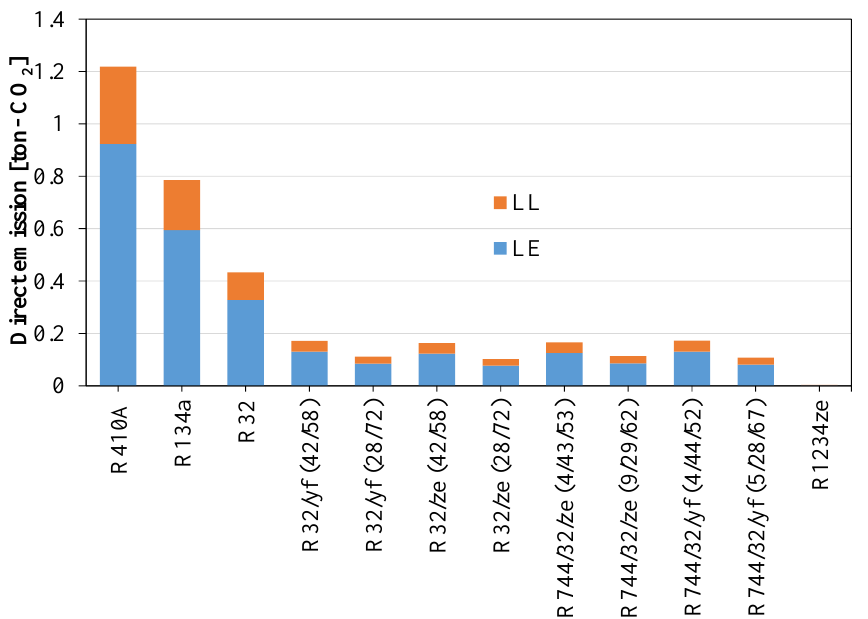
Figure 13. Direct equivalent CO 2 emissions for refrigerants when used in domestic applications.